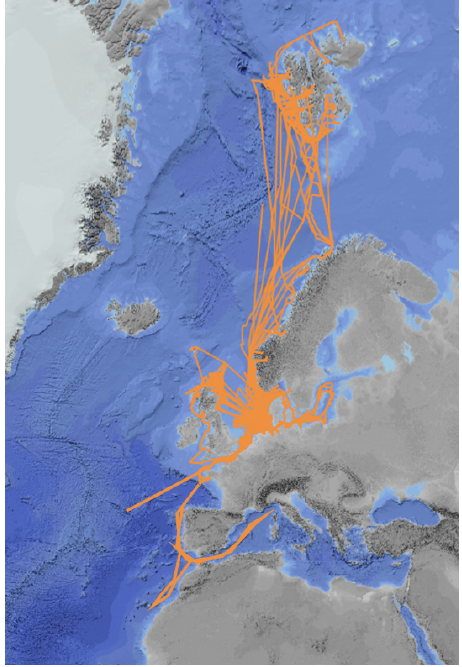
Figure 4: Operation areas of Heincke 1990 -